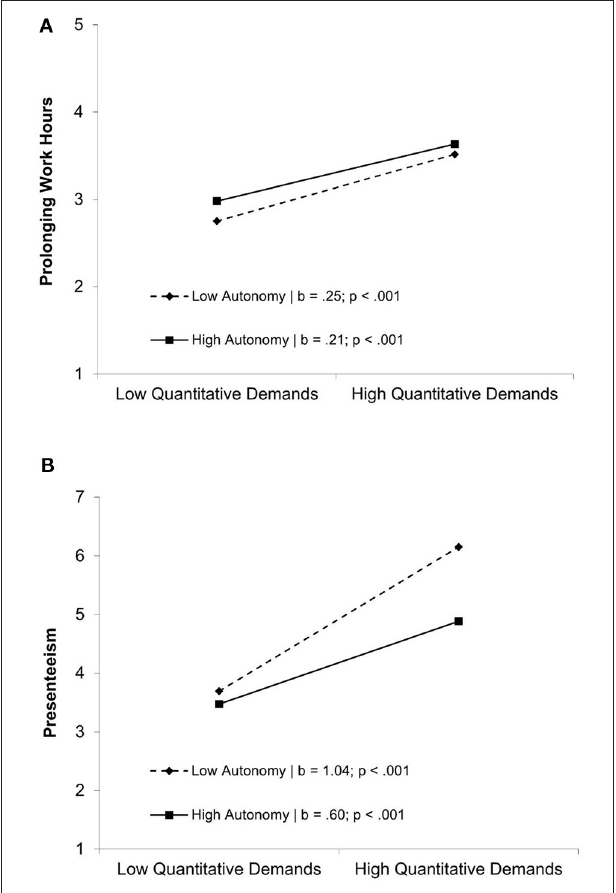
FIGURE 4 | (A) Moderating effect of autonomy for the relationship between quantitative demands and prolonging of working hours. (B) Moderating effect of autonomy for the relationship between Quantitative Demands and